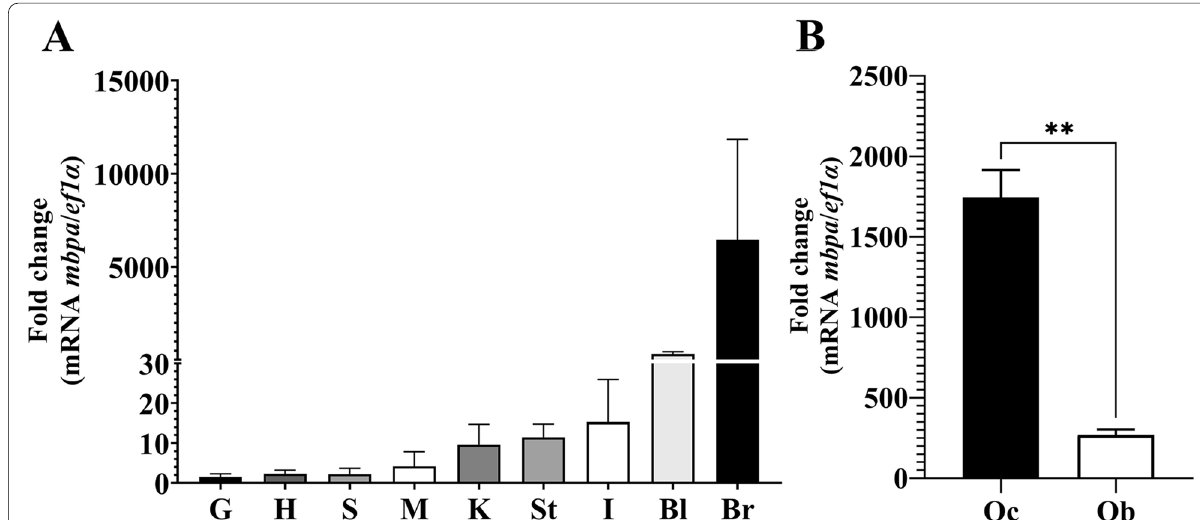
Fig. 3 Relative gene expression of mbpa transcripts in P . brachypomus tissues. A Basal mbpa gene expression in several tissues. G gills, H heart, S spleen, M muscle, K kidney, St stomach, I intestine, Bl blood, Br brain. B Basal mbpa gene expression in two brain regions. Oc optic chiasm, Ob olfactory bulb. ef1a was used as a reference gene. ** p < 0.01